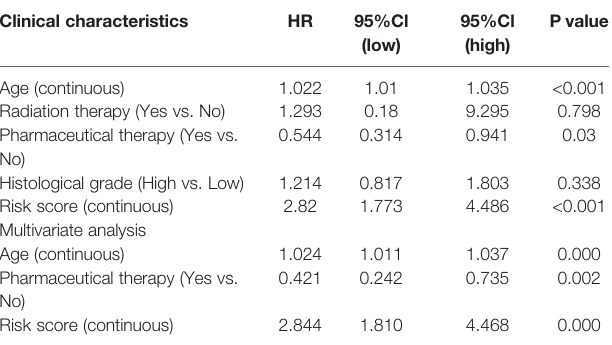
TABLE 5 | Relative proportion of 22 types of immune cells in high and low risk score